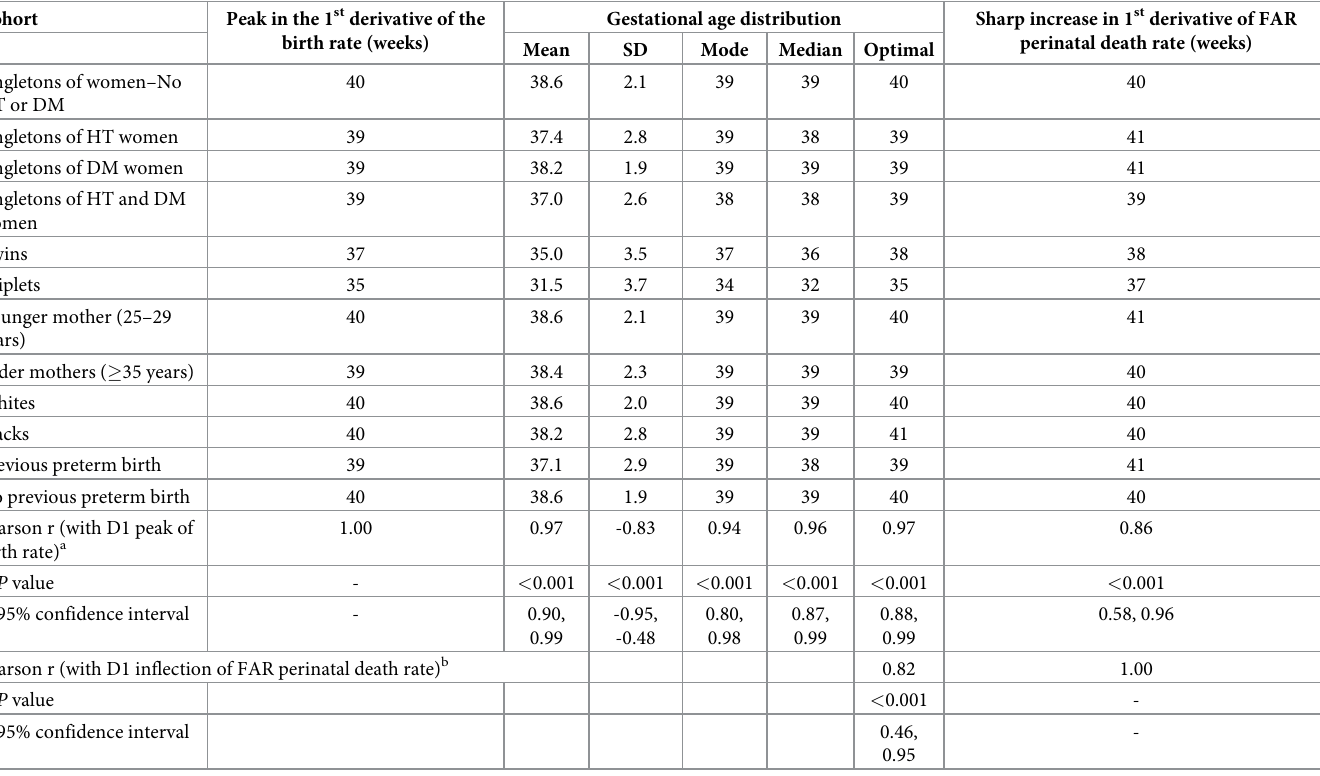
Table 1. Clustering and correlation between the gestational week at which the first derivative of the birth rate peaked vs the mean, mode, median and standard devi- ation of the gestational age distribution, optimal gestational age and the gestational week at which the first derivative of the fetuses-at-risk perinatal death rate increased sharply, low- and high-risk cohorts, United States, 2004–2015.